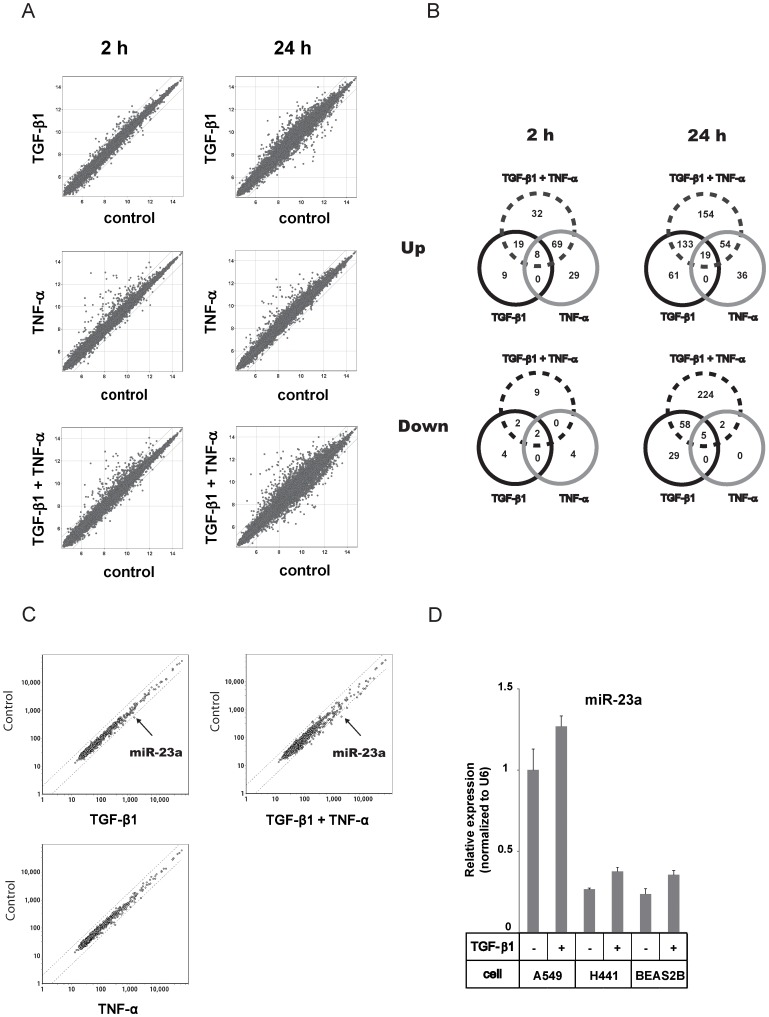
Expression profiling of mRNA and miRNA.(A) Scatter plot representation of the transcripts in the samples treated with TGF-β1 and/or TNF-α for 2 h or 24 h (Y-axis), compared to those of unstimulated control (X-axis). The transcripts are plotted using log2 normalized data. The threshold of transcript levels was set as induced >2.0-fold or repressed <0.5-fold, and is indicated in each scattergram. (B) Venn diagram illustrating the overlap between genes upregulated (Up) or downregulated (Down) by TGF-β1 and/or TNF-α treatment for 2 h or 24 h. The threshold of transcript levels was set as induced >2.0-fold or repressed <0.5-fold. The figures indicate the number of annotated genes. (C) Scatter plot representation of mature miRNAs in the samples treated with TGF-β1 and/or TNF-α for 24 h (X-axis), compared to those of unstimulated control (Y-axis). The threshold of miRNA levels was set as induced >2.0-fold or repressed <0.5-fold, and is indicated in each scattergram. (D) Quantitative RT-PCR for mature miR-23a. A549, H441 and BEAS2B cells were treated with TGF-β1 for 24 h. Expression was normalized to that of U6. Error bars: SD.